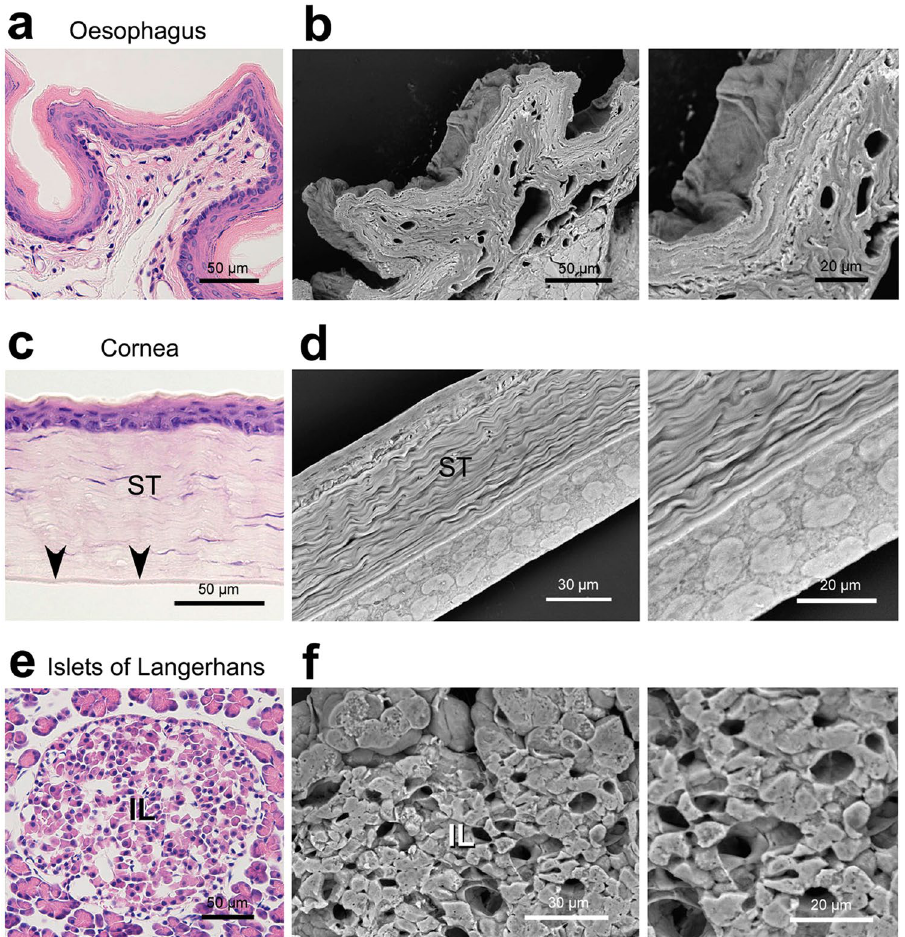
Figure 5. Representative micrographs of rat oesophagus, cornea, and pancreas. Electron micrographs were taken from 30 µ m sections. ( a , b ) Oesophagus. Thick PS-LvSEM demonstrates the multiple layers of stratified epithelium. ( c , d ) Cornea. The face image of endothelium, rarely seen in 5 µ m sections (arrowheads in c ), is clearly shown in the 30 µ m section. Note the collagen fibres in its stroma (ST). ( e , f ) Islets of Langerhans (IL) in the pancreas. The capillary network is seen, a characteristic of endocrine